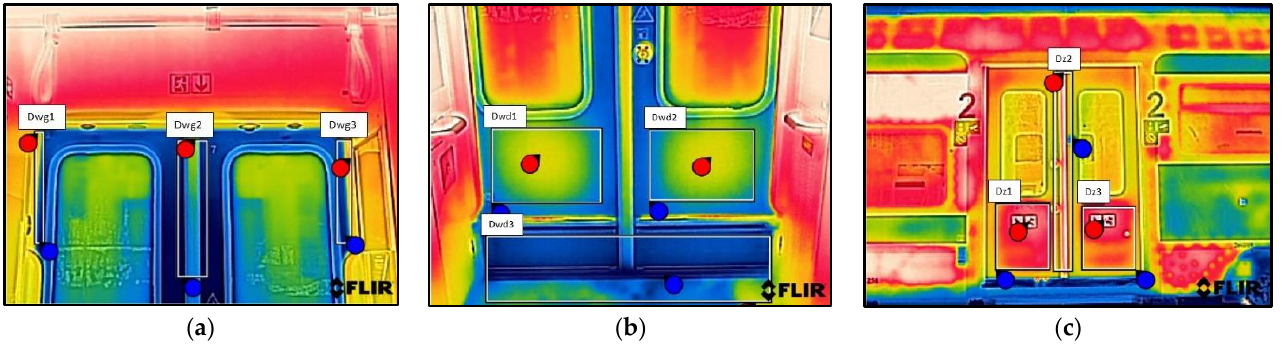
Figure 9. Defined locations for calculating the average door temperature value: ( a ) the upper part from inside the vehicle — Dwg1, Dwg2, Dwg3; ( b ) the lower part from inside the vehicle — Dwd1, Dwd2, Dwd3; ( c ) the upper and lower parts on the outside of the vehicle — Dz1, Dz2, Dz3. where: — the red dots indicate the locations with the highest recorded temperature; — the blue dots indicate the locations with the lowest recorded temperature.